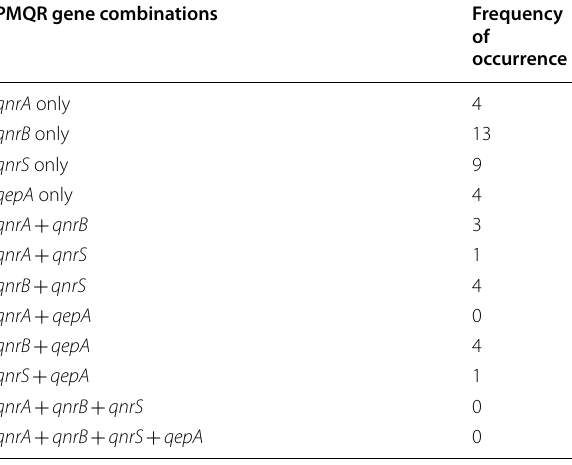
Table 5 Carriage of different PMQR gene combination by the forty-three isolates carrying PMQR genes PMQR gene combinations Frequency